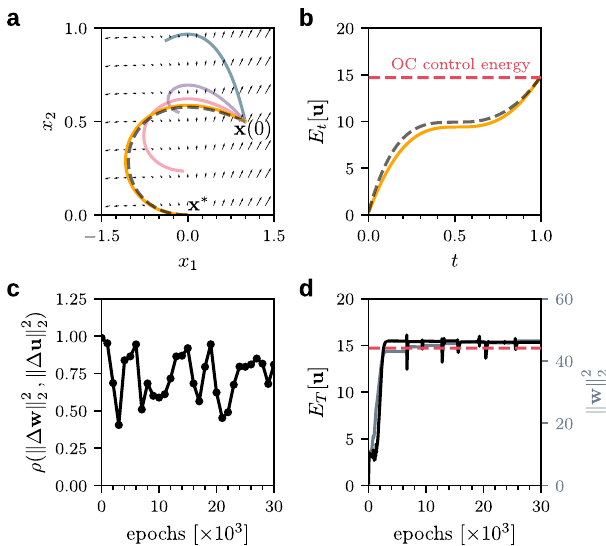
Fig. 2 Controlling a two-node system with AI Pontryagin. a Different AI Pontryagin-controlled trajectories of a linear system with x ð 0 Þ ¼ ð 1 ; 0 : 5 Þ T , x (cid:1) ¼ ð 0 ; 0 Þ T , and T ¼ 1 after 500 (blue), 1500 (purple), 2000 (red), and 30000 (orange) training epochs with learning rate η ¼ 0 : 02. The dashed black line is the corresponding optimal control trajectory and black arrows indicate the vector fi eld of the linear dynamical system f ð x ; u Þ ¼ A x þ B u with matrices A and B as in Eq. (8). b Evolution of the control energy E t ½ u (cid:3) of AI Pontryagin after 30000 training epochs (solid orange line) and of optimal control (dashed black line). c Correlations ρ between squared norm differences of ANN weights w and control inputs u . d The control energy E ½ u (cid:3) (black solid line) and squared norm of ANN weights w (solid gray T line) of AI Pontryagin as a function of training epochs. In panels ( b , d ), we indicate the total OC control energy by a dashed red